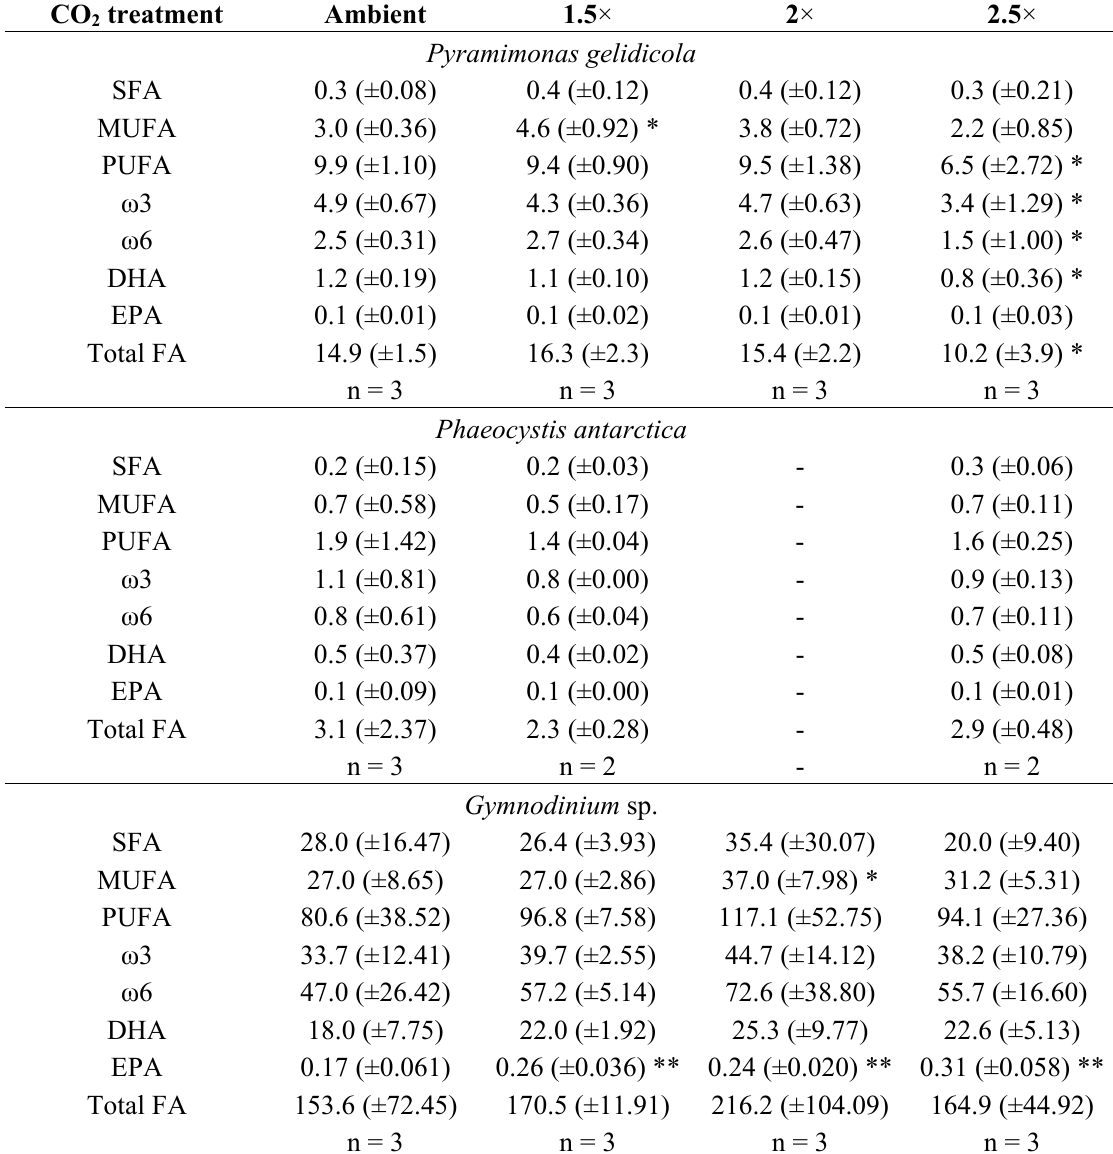
Table 6. Fatty acid content in pg/cell for all three phytoplankton species at the respective CO treatments. SD in brackets, n = number of samples. * p < 0.05; ** p < 2